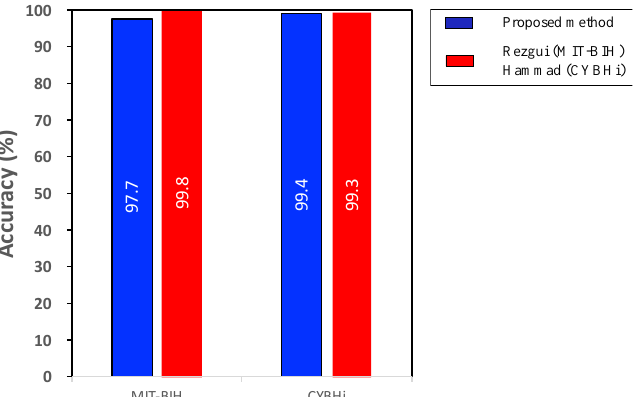
Figure 15. The evaluation result of the proposed method using MIT-BIH and Check Your Bio-signals Here initiative (CYBHi) databases. The experiment using MIT-BIH is compared with [35] and the other using CYBHi with [39].